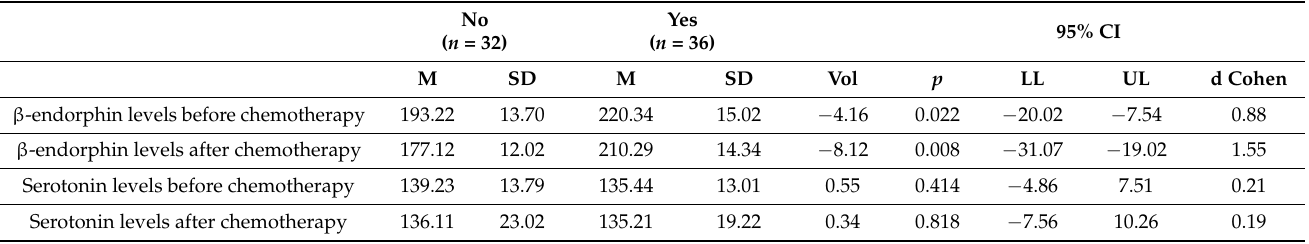
Table 10. The level of β -endorphins, serotonin, and the survival of the women in the study group- with ovarian cancer (III–IV stage according to